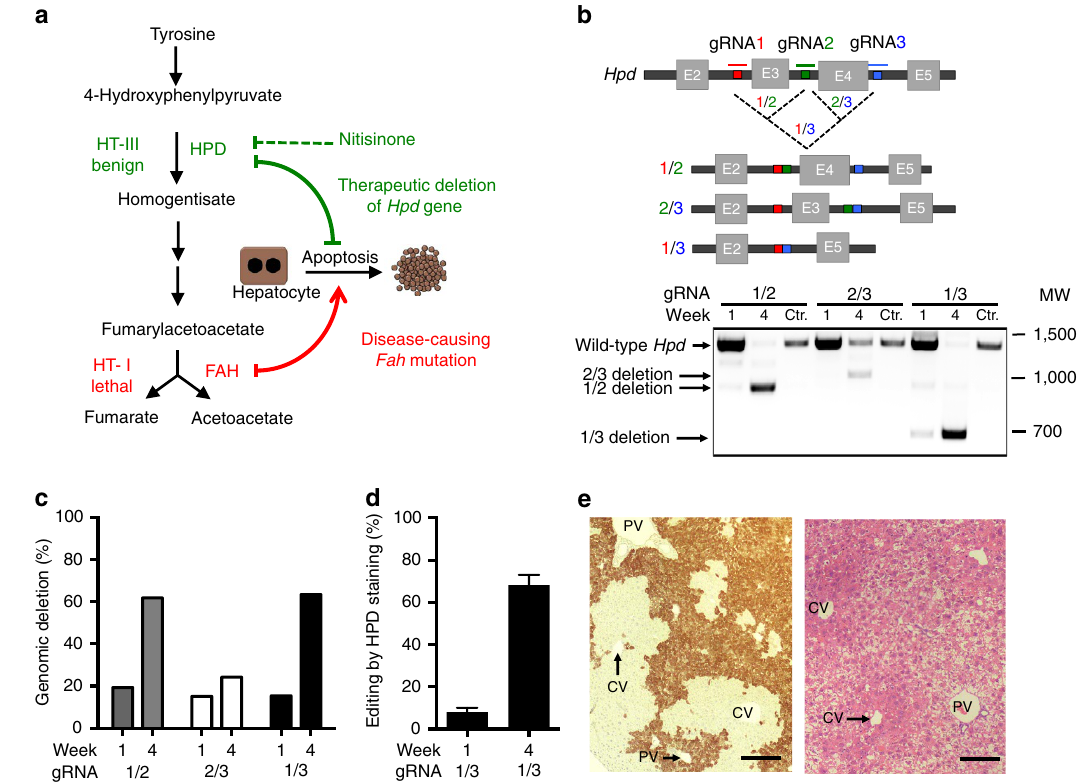
Figure 1 | Metabolic reprogramming for HT-I. ( a ) The therapeutic conversion of HT-I to HT-III can be accomplished genetically by deleting the Hpd gene. ( b ) Schematic representation of the editing strategy using several gRNA pairs in vivo and validation by PCR of liver tissue. ( c ) In vivo editing efficiency determined by high throughput sequencing (pooled DNA libraries from three livers in each group). ( d ) Editing efficiencies measured by immunostaining for HPD using gRNA1/3 ( N ¼ 3). ( e ) Representative image of immunostaining for HPD (left) and haematoxylin and eosin stain (right) showing editing localized to the pericentral areas (CV). CV, central vein; MW, molecular weight marker given in base pairs; PV, portal vein. Scale bar, 50 m m. Bars represent mean ( ± s.d. for d